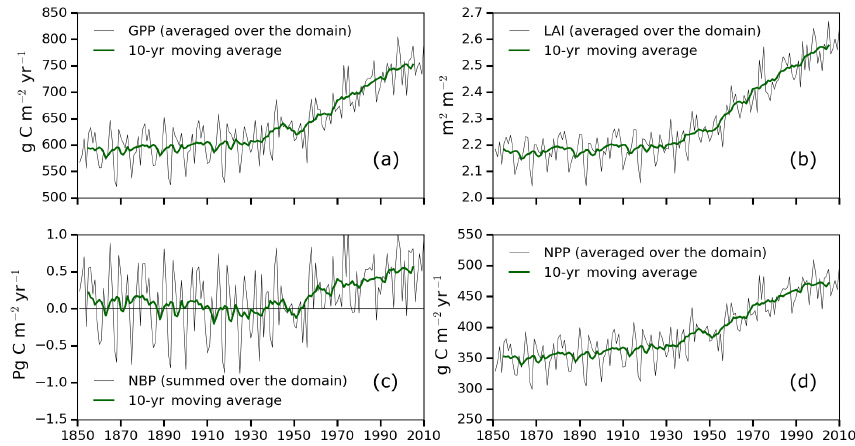
Figure 10. Time series evolution of (a) domain-averaged GPP (gCm − 2 yr − 1 ), (b) domain-averaged LAI (m 2 m − 2 ), (c) domain total NBP (PgCm − 2 yr − 1 ) and (d) domain-averaged NPP (gCm − 2 yr − 1